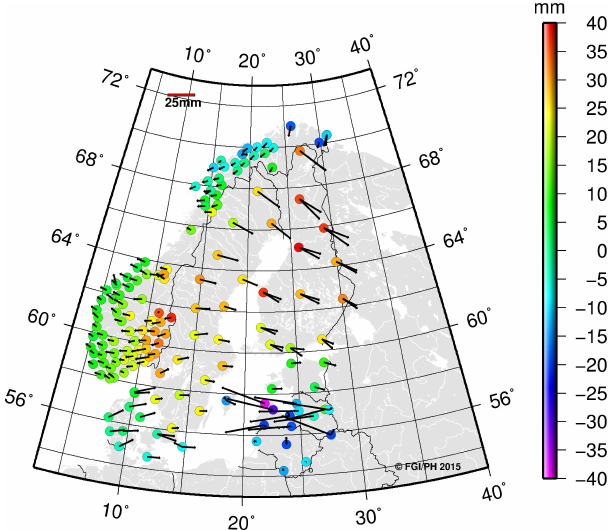
Figure 6: Coordinate difference NKG ETRF 00 minus national ETRS89